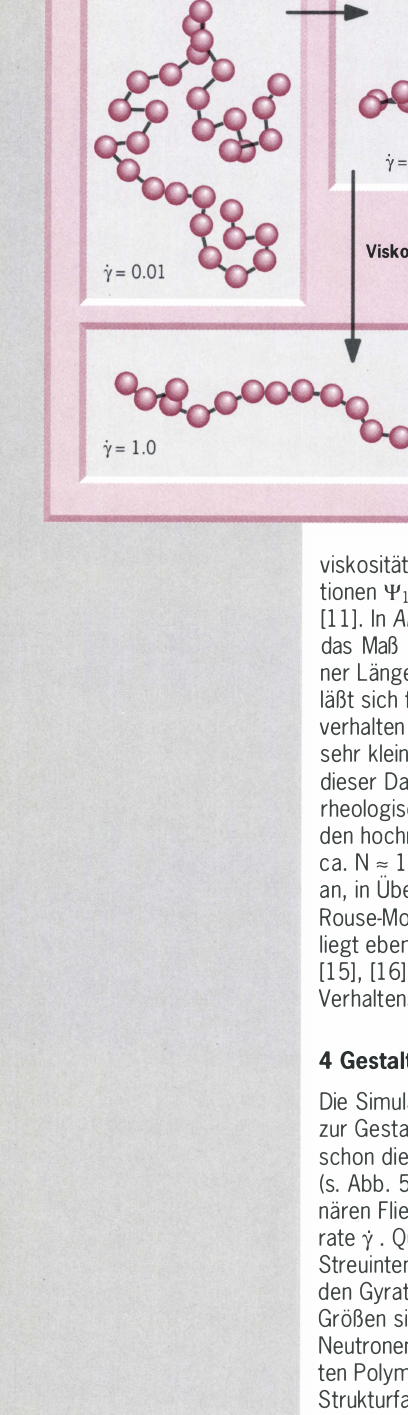
Fig. 5: Conformations of individual polymer chains (N = 30) in a flowing melt with a total of 1000 chains per system